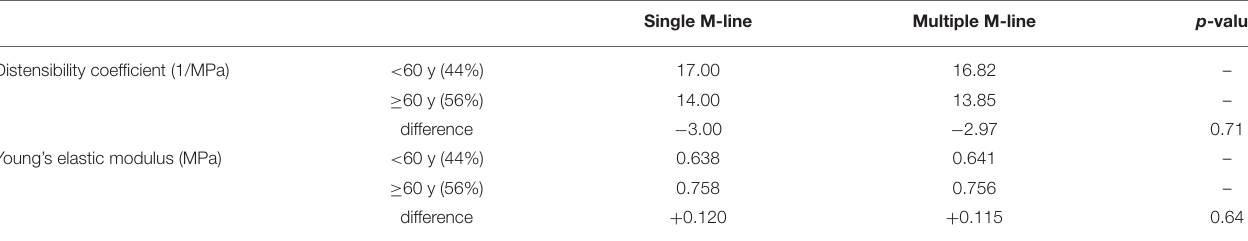
TABLE 3 | Feasibility of detecting age-related changes in